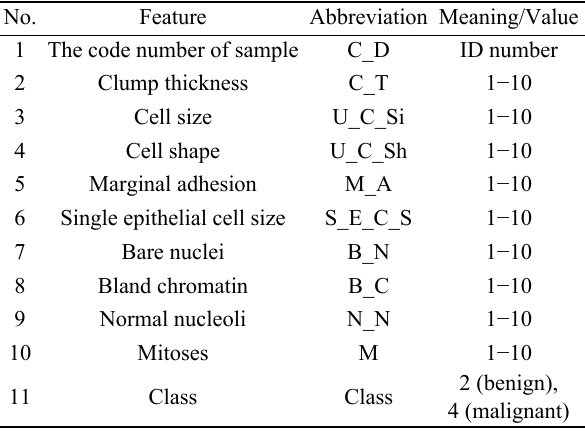
Table 1 Meaning/value of cell